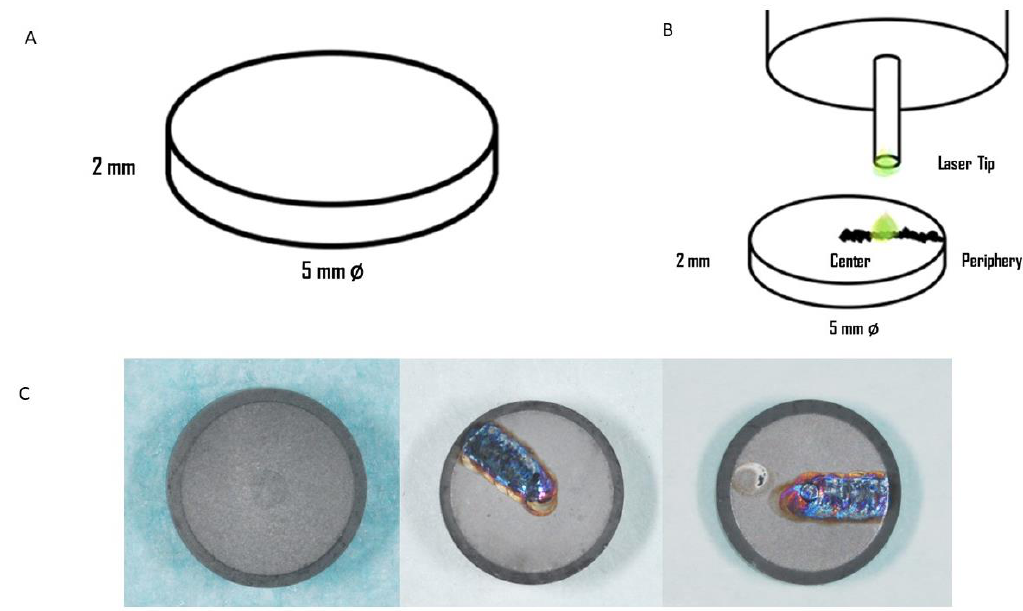
Figure 1. (A ) Disks used in the present study. ( B ) The titanium disks during laser irradiation. ( C ) The sandblasted and acid-etched surface before and after the laser